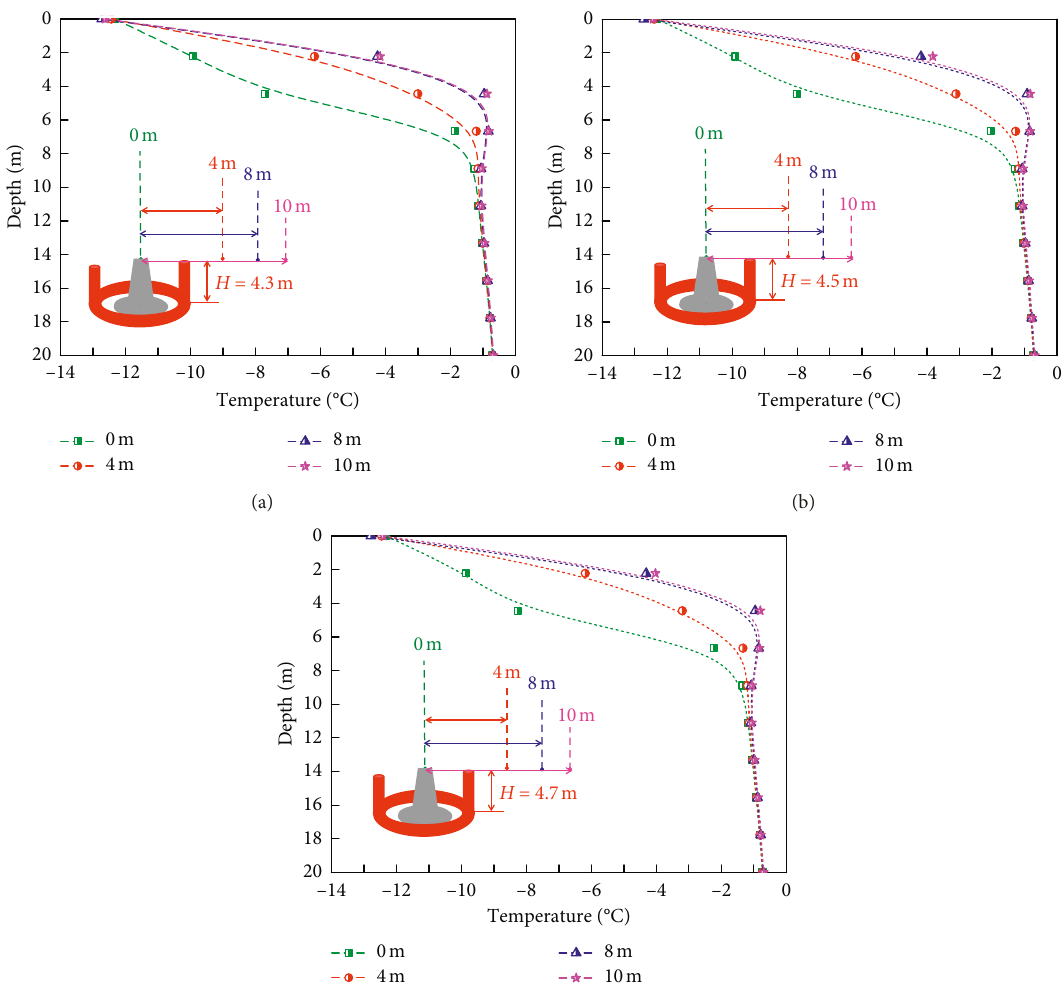
Figure 9: Temperature in the footing centrelines on January 15. (a) H � − 4.3m. (b) H � − 4.5m. (c) H � − 4.7m.